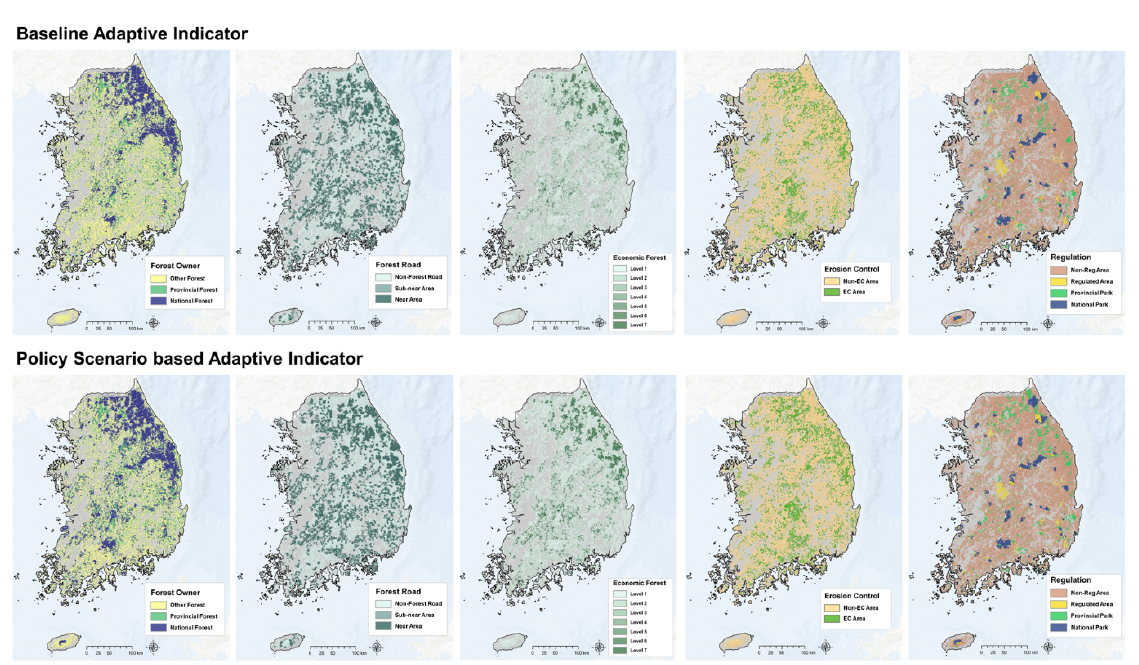
Figure 2. Maps of climate input variables for 2011, 2050, and 2092.